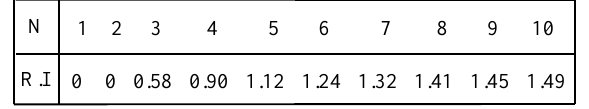
Table 2. Ratio index for values of N